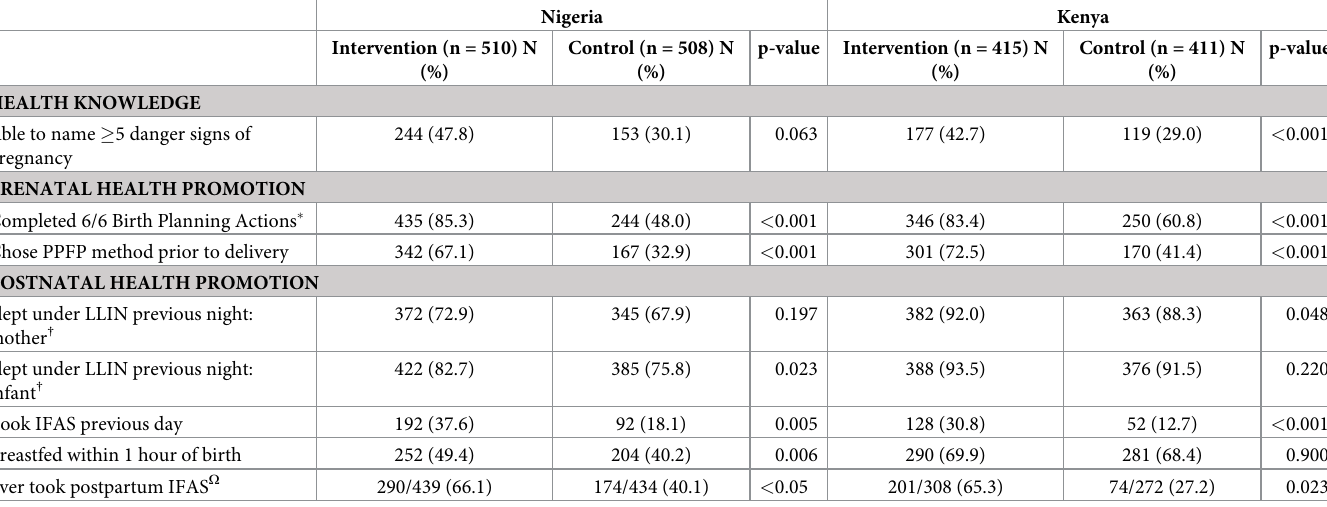
Table 7. G -ANC effect on health knowledge and uptake of health promoting